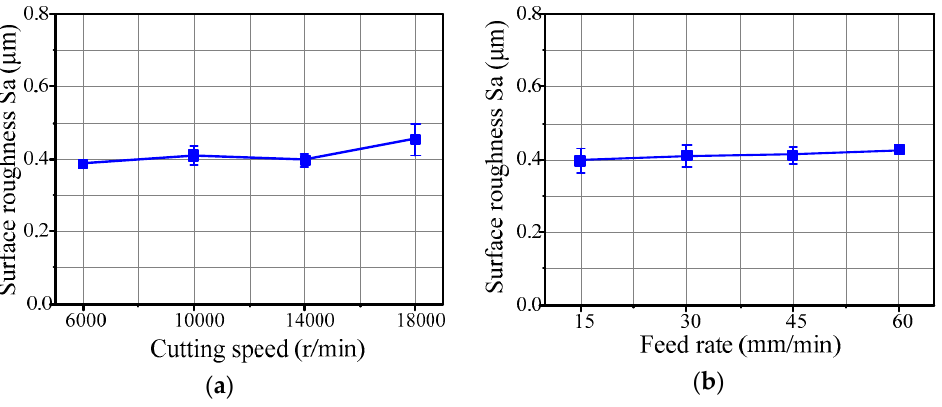
Figure 9. ( a ) Effects of spindle speed on surface roughness ( f = 45 mm/min); and ( b ) the effects of the feed rate on surface roughness ( n = 10,000